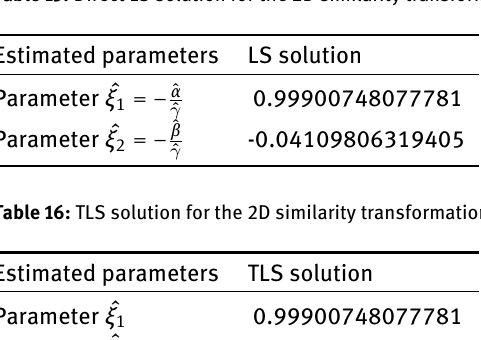
Table 15: Direct LS solution for the 2D similarity transformation